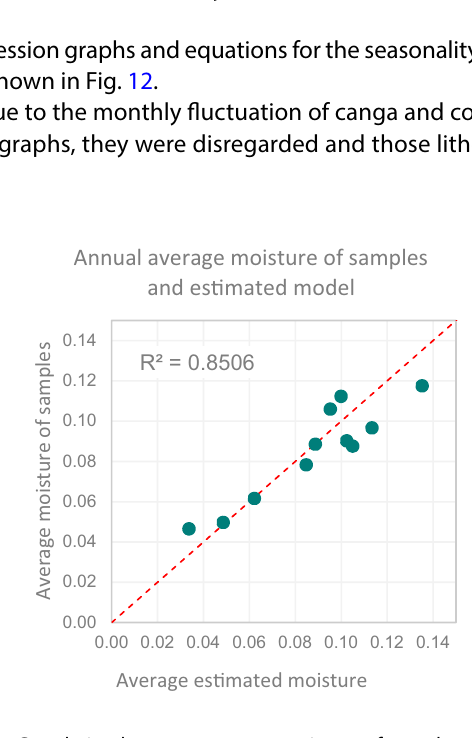
Fig. 11 Correlation between average moisture of samples and esti- mated average